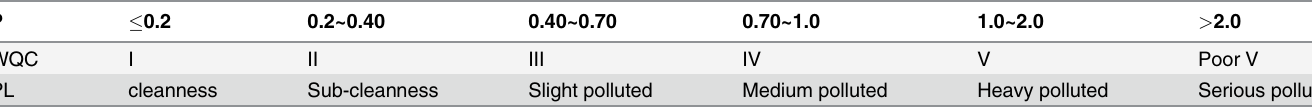
Table 3. Standard of comprehensive pollution index classi fi